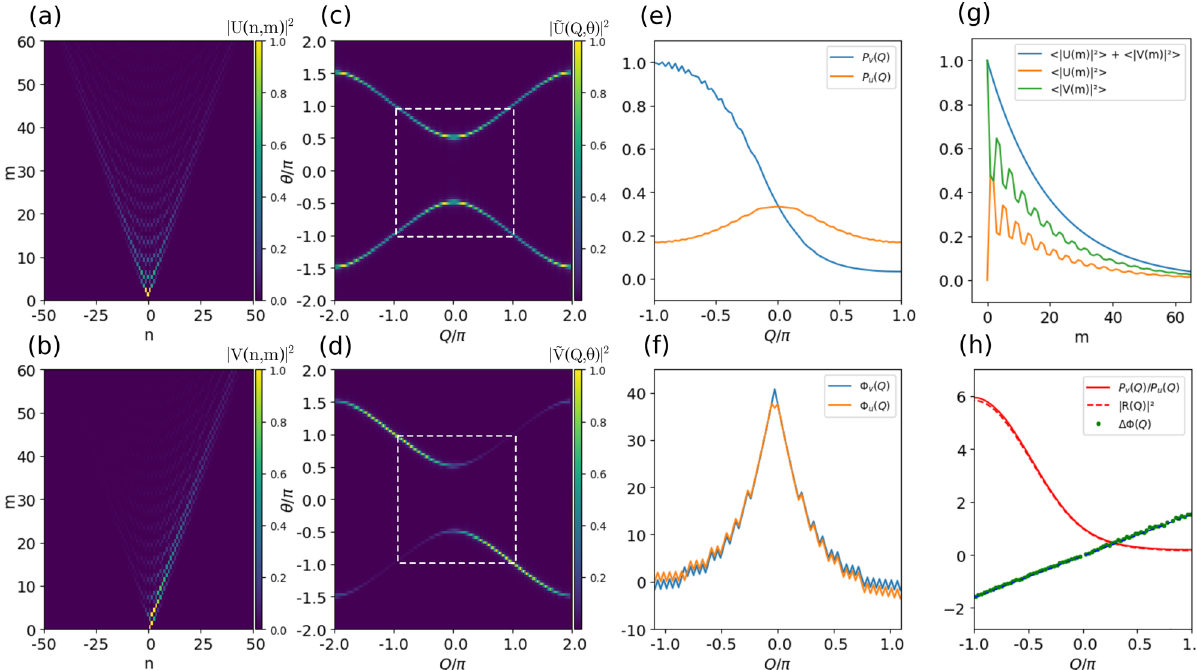
Fig. 4 Numerical results. Numerical simulations of Eqs. (1) and (2) showing the impulse responses of the two loops ( a , b ) and their associated 2D Fourier transforms j ~ U ð Q ; θ Þj 2 ( c ), j ~ V ð Q ; θ Þj 2 ( d ). The squares in white dashed lines in ( c , d ) represent the fi rst Brillouin zone. The simulations are made using a dissipation rate similar to the one measured in the experiment ( α = 0.07) and no phase modulation ( Φ ( m ) = 0 ∀ m ). e Spectral power distributions P ð Q Þ ¼ j ~ U ð Q ; θ ð Q ÞÞj 2 (orange line) and P ð Q Þ ¼ j ~ V ð Q ; θ ð Q ÞÞj 2 (blue line) measured along the upper spectral bands in ( c , d ). f Spectral U þ V þ